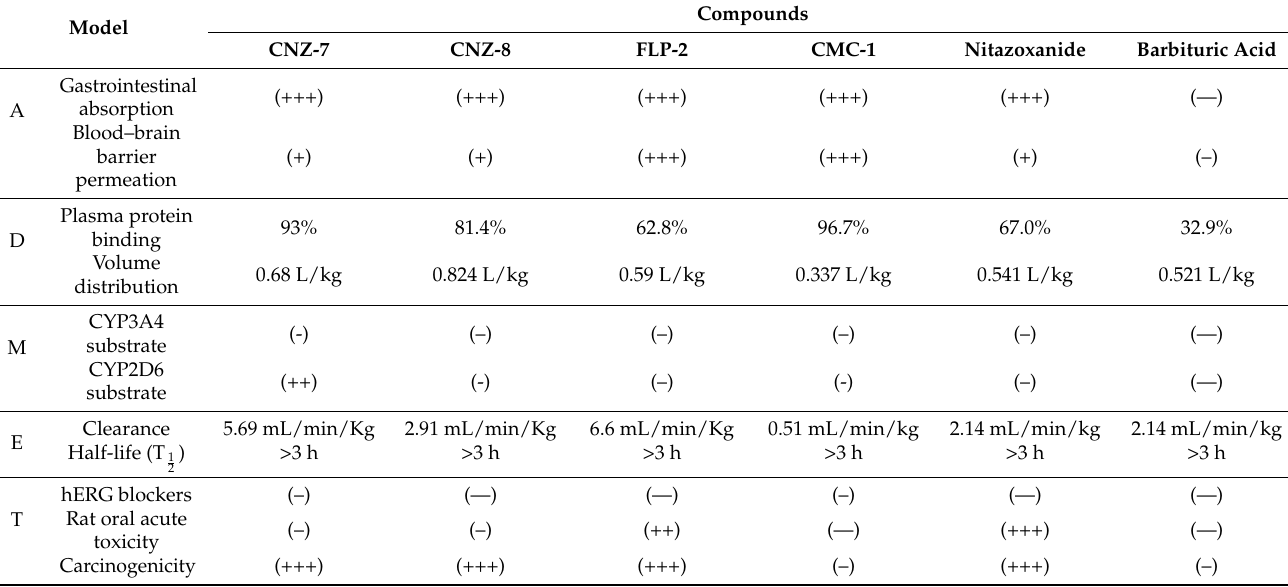
Table 4. Pharmacokinetic predictive values calculated with ADMETLab 2.0 for compounds